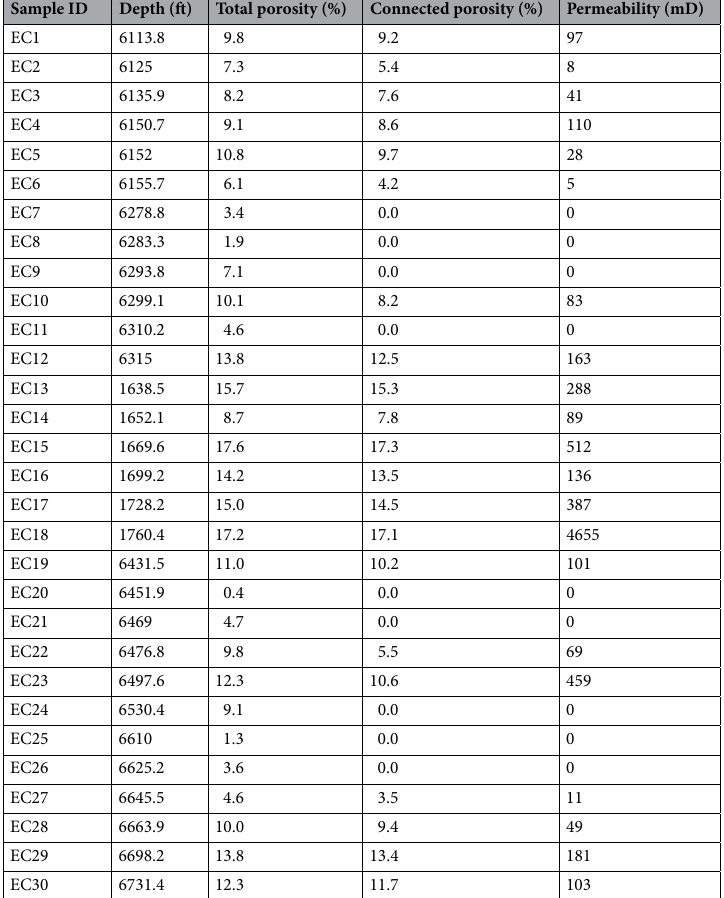
Table 1. Porosity, connected porosity and permeability measurements of each study sample from the English Channel. Measurements from the other sample suites are available in their respective publications 18,22